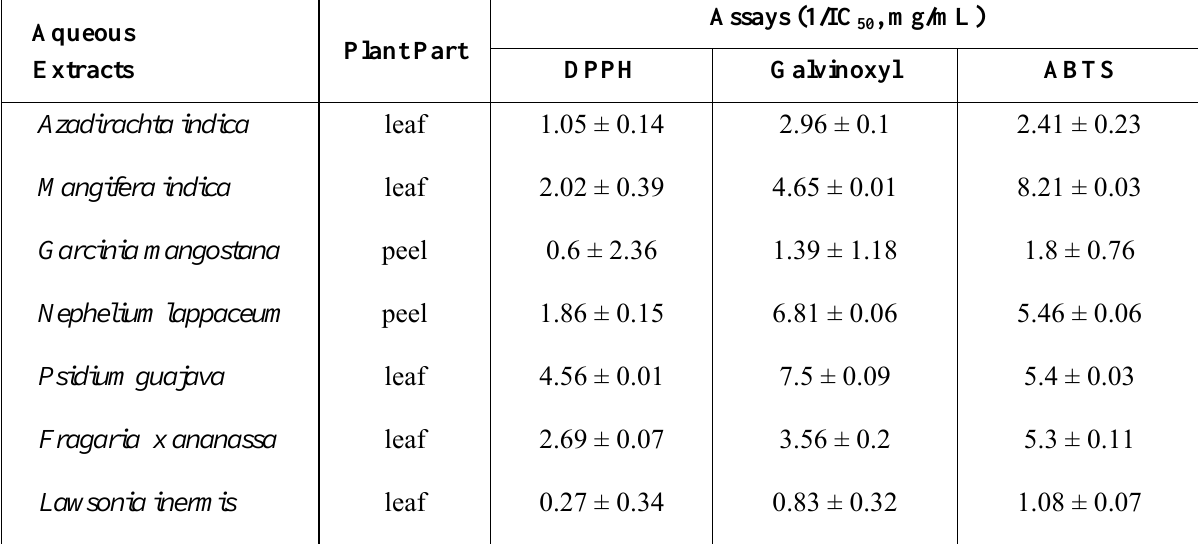
Table 3. Free radical scavenging activity of various Malaysian plants extracted in